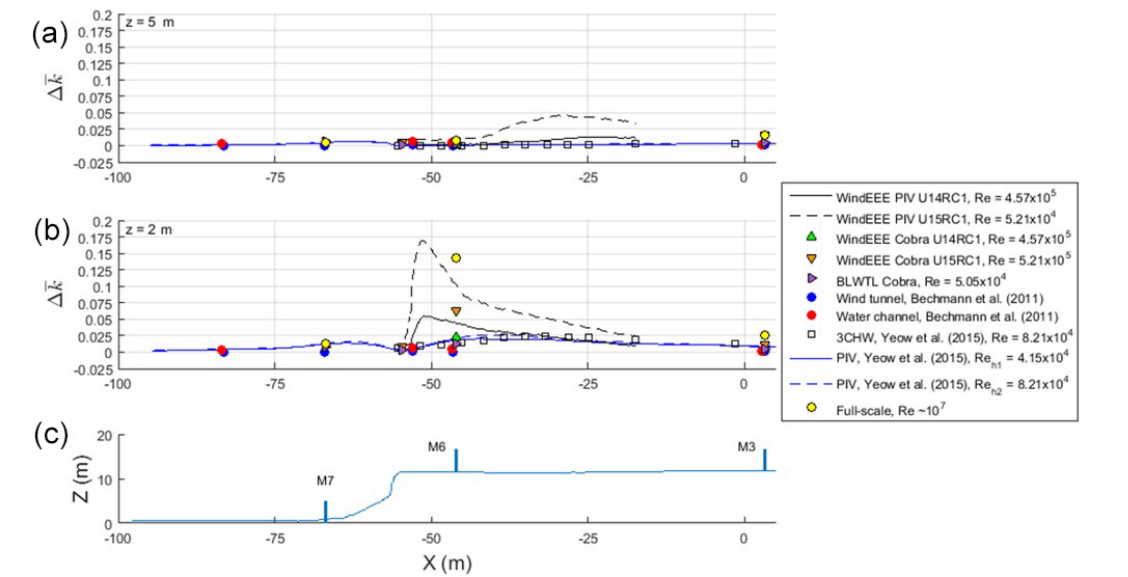
Figure 15. Horizontal profiles of TKE increment (cid:49)k from PIV and Cobra probe measurements (WindEEE and BLWTL cases) at (a) z = 5m and (b) z = 2m above hill surface, with (c) showing hill profile. Results from full scale and other previous physical experiments shown for comparison.